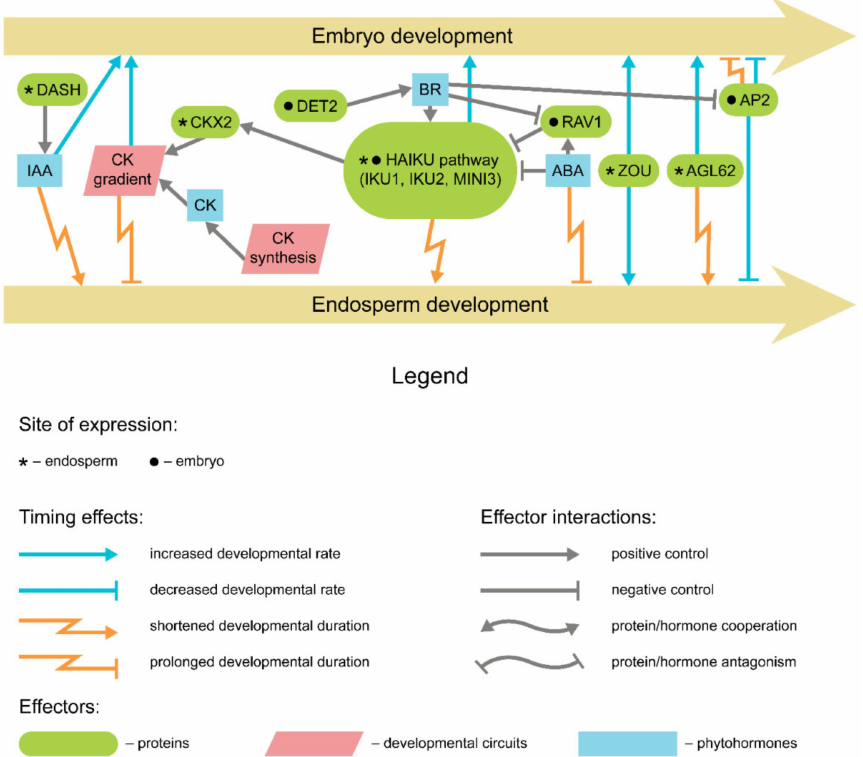
Figure 4. Key regulators of endosperm development timing and their effect on embryo development